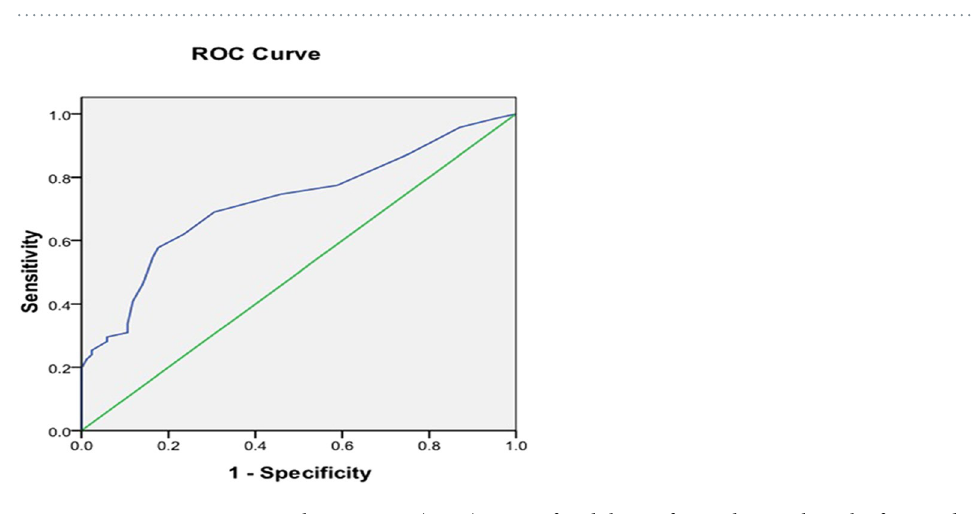
Figure 3. Receiver-operating Characteristic (ROC) curve of nodule size for predicting the risk of cervical LNM. Blue line shows an ROC plot for nodule size with an AUC of 0.72 (95% CI: